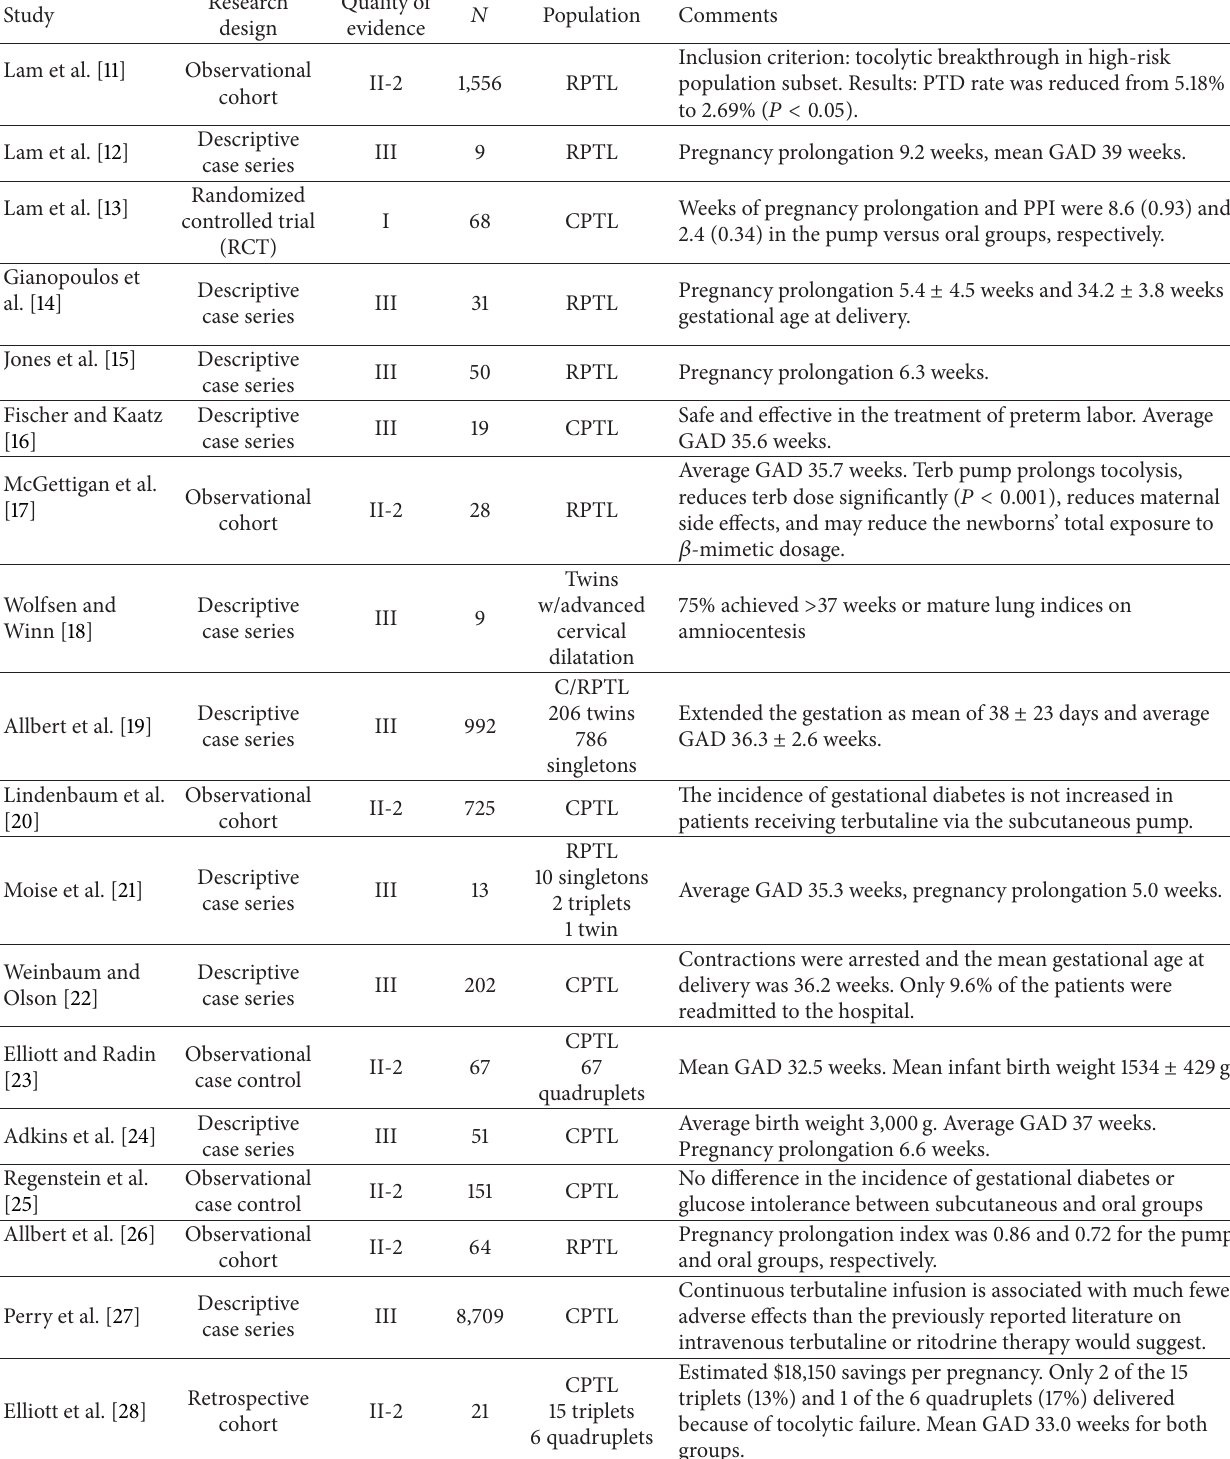
Table 1: Evidence-based medicine and continuous subcutaneous terbutaline infusion review of efficacy literature.